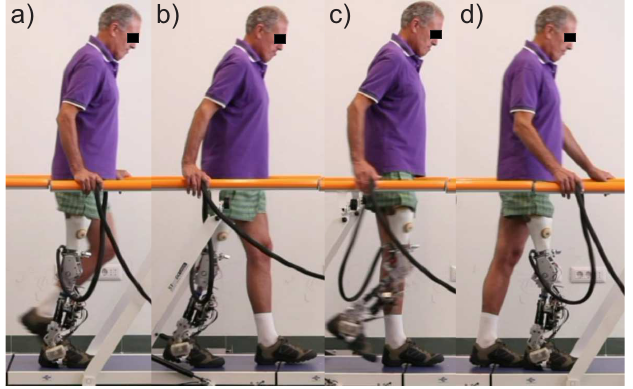
Figure 3. Steady-state gait phases of an amputee walking. From left to right: ( a ) single stance prosthetic limb ( SS ); ( b ) double stance prosthetic-sound limb ( DS p stance sound limb ( SS ); and ( d ) double stance sound prosthetic limb ( DS s